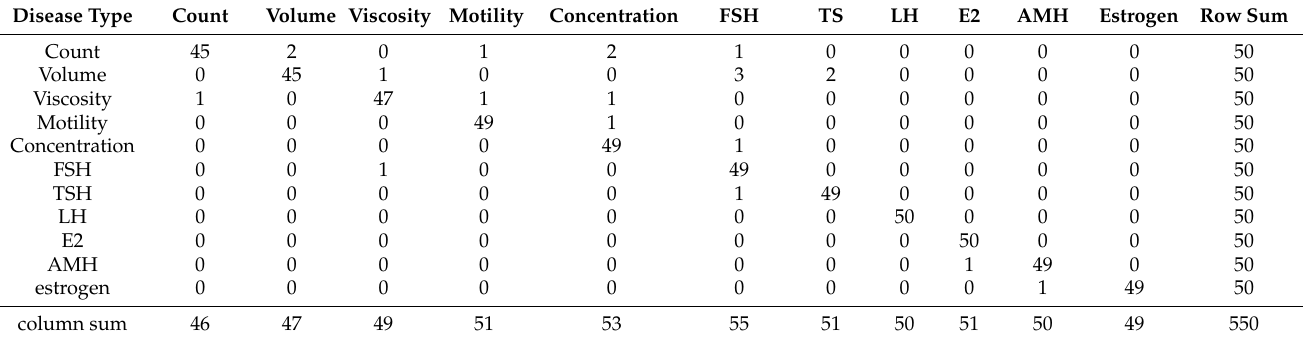
Table 7. Confusion matrix of the diagnostic result of the pregnancy hormones: 10-fold cross-validation. Disease